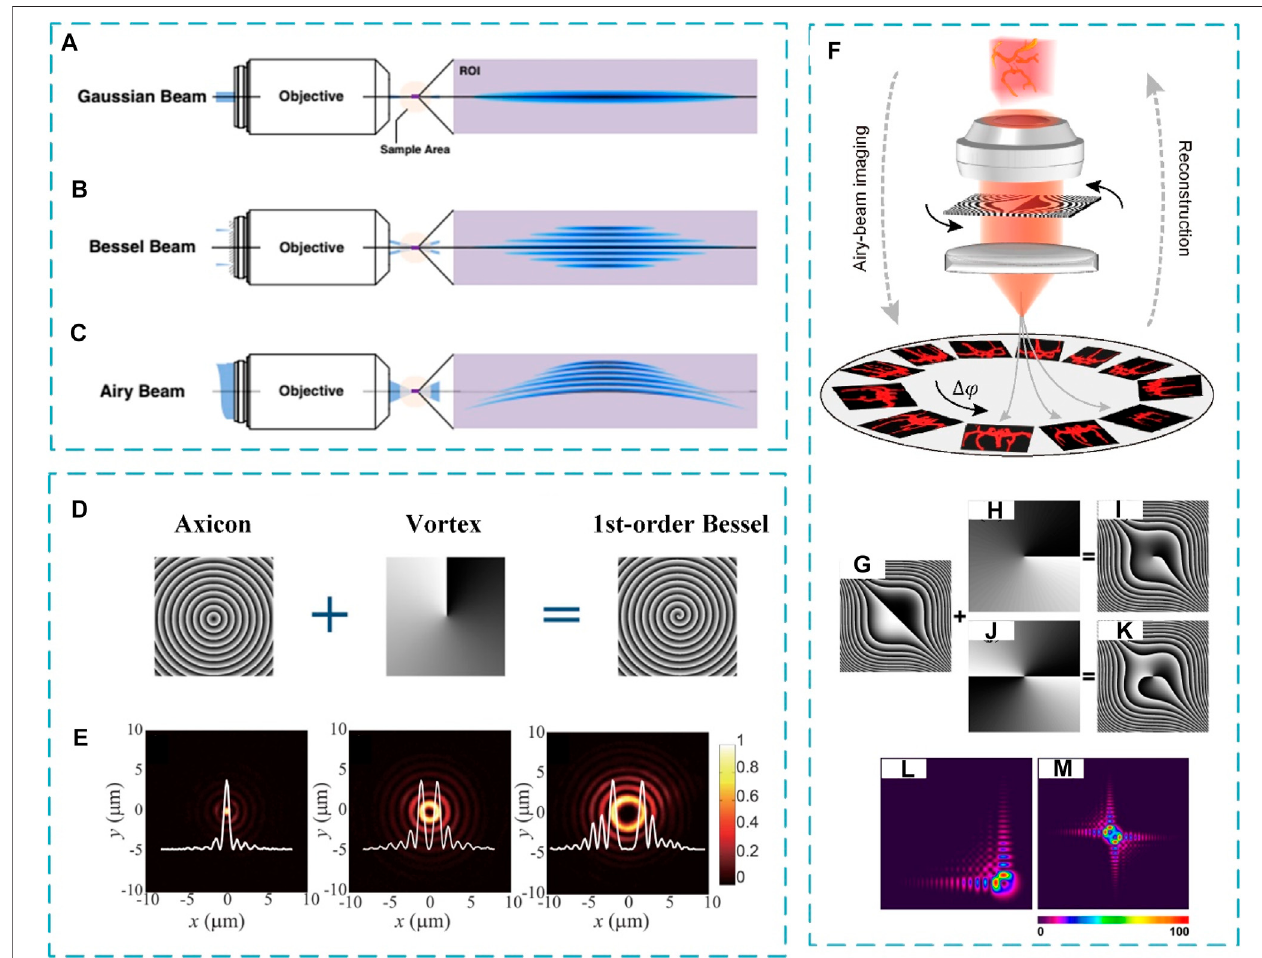
FIGURE 7 | (A – C) Creation of (A) apertured Gaussian, (B) Bessel, and (C) optical Airy beams [80]. (D) Phase masks on the SLM and their superposition [81]. (E) Lateral beam pro fi les of the 0th-, 2nd-, and 4th-order Bessel beams [82]. (F) Principle of the Airy beam tomographic microscopy. The Airy beams of varying azimuthal angles illuminate the sample and tomographically reconstruct the sample structure using the recorded perspective images [83]. (G – K) Principle of the phase design of the vortex Airy beams [48]. (L,M) Simulated intensity distributions of single (L) and dual (M) vortex Airy beams [48]. Reproduced with permission from Springer Nature [82], reprinted with permission of OSA [80, 81, 83], and reprinted with the permission of AIP Publishing [48].